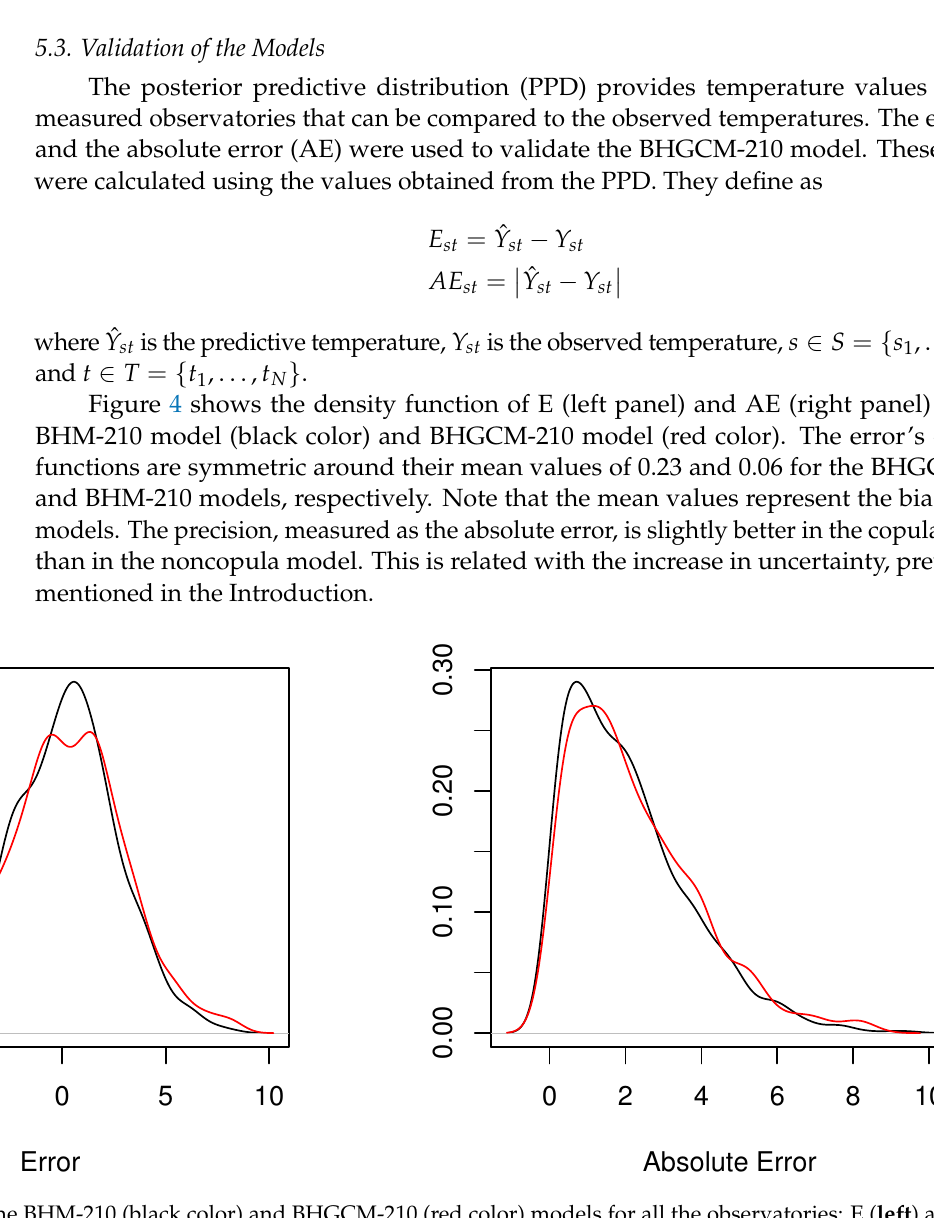
Figure 4. Validation of the BHM-210 (black color) and BHGCM-210 (red color) models for all the observatories: E ( left ) and AE ( right ) density